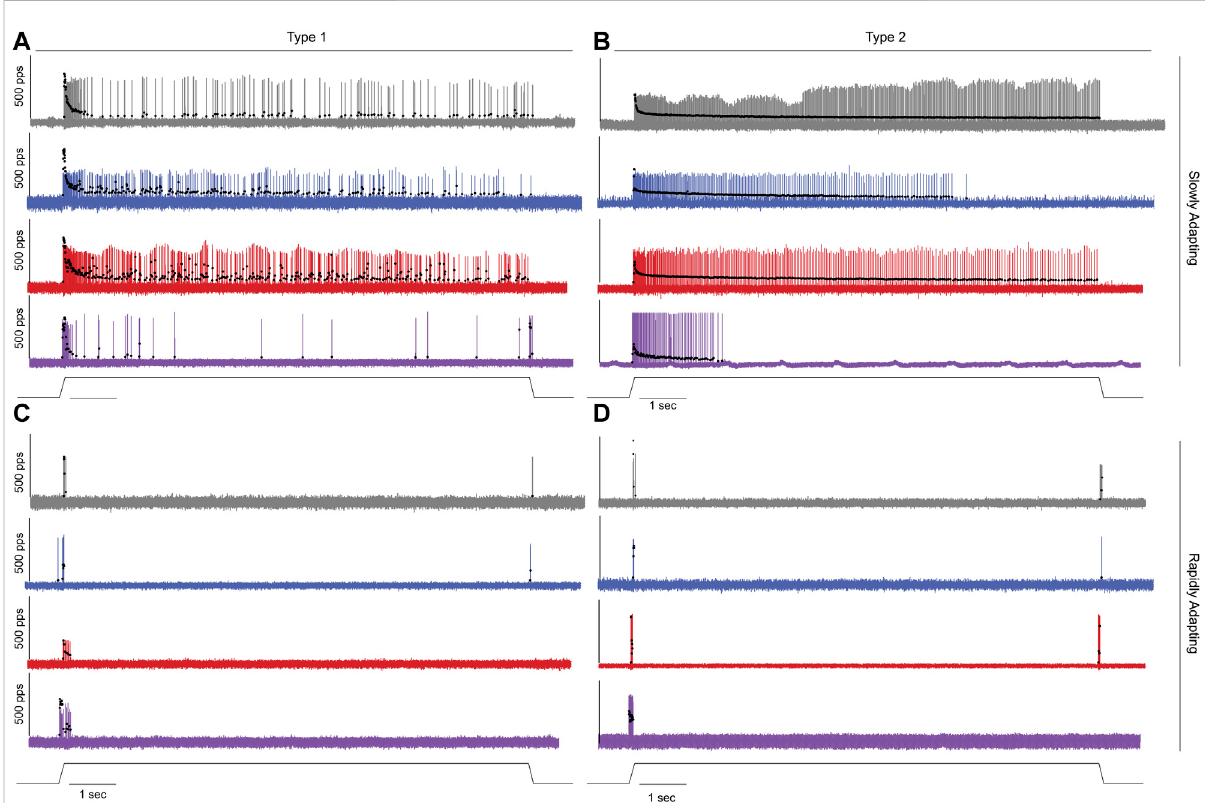
FIGURE 5 Impaired Cutaneous Mechanosensory Neuron Code After Cancer Treatment. Representative cases of spiking activity in control (grey), OX (blue), cancer (red), and cOIN (purple) as a measure of sensory encoding in slowly adapting type I SA1: Merkel corpuscles; (A) and type II SA2: Ruf fi ni endings; (B) and rapidly adapting Meissner corpuscles RA1; (C) and Pacinian corpuscles RA2; (D) . Black circles plot instantaneous fi ring rates (pps) of correspondingspike(action potential)intervals.Solidlinebelowvoltagerecordingsindicatesthedynamic andstaticcomponentsofthenatural stimulation paradigm, i.e. displacement of the plantar skin in vivo utilized to study the cutaneous neurons (1 mm from resting length: